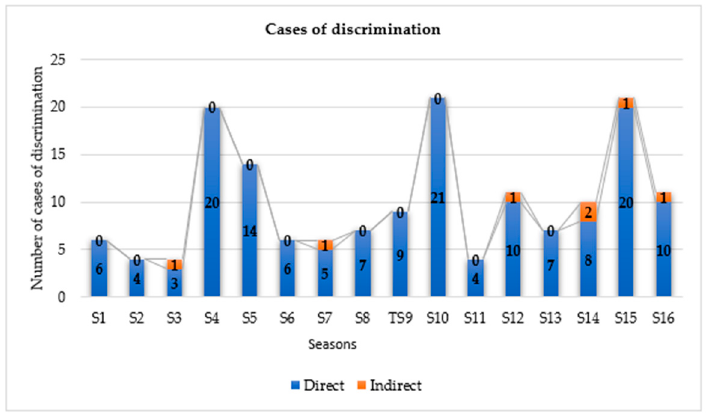
Figure 3. Cases of discrimination. Source: Own elaboration.